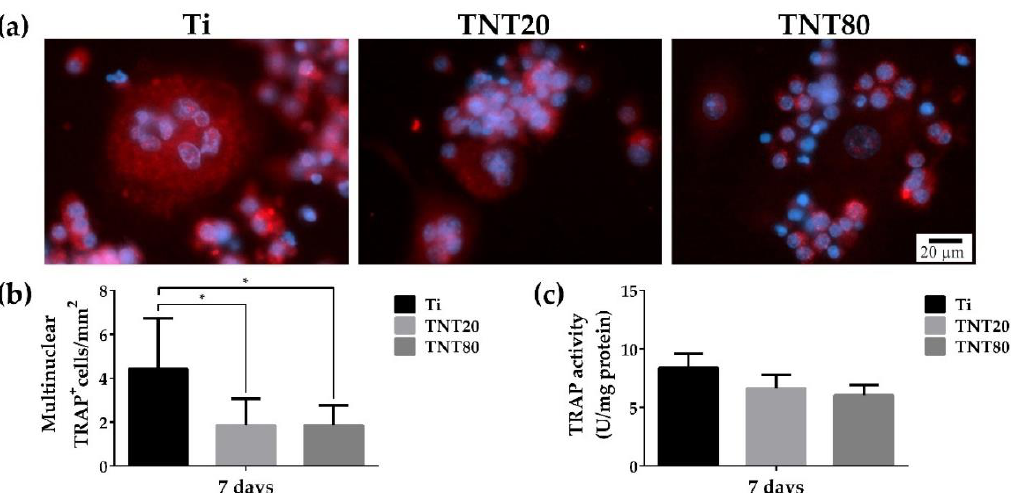
Figure 8. Evaluation of the tested surfaces on the osteoclastogenic differentiation: ( a ) The immunofluorescence staining of the intracellular TRAP protein revealed differences between the tested materials with the flat Ti support leading to the formation of larger TRAP-positive multinucleated cells (more than 3 nuclei), while on the TNT surfaces a more reduced number and small multinucleated TRAP cells could be observed. The TRAP signals are represented by red fluorescence, while the nuclei were stained with DAPI (blue fluorescence). All images were captured at the same magnification (scale bar represents 20 µm). ( b ) The average number of TRAP positive cell per mm 2 . Results are expressed as means ± SD ( n = 7, * p < 0.05 vs. Ti). ( c ) TRAP activity determination. Results are expressed as mean ± SD ( n = 3, no statistical differences were